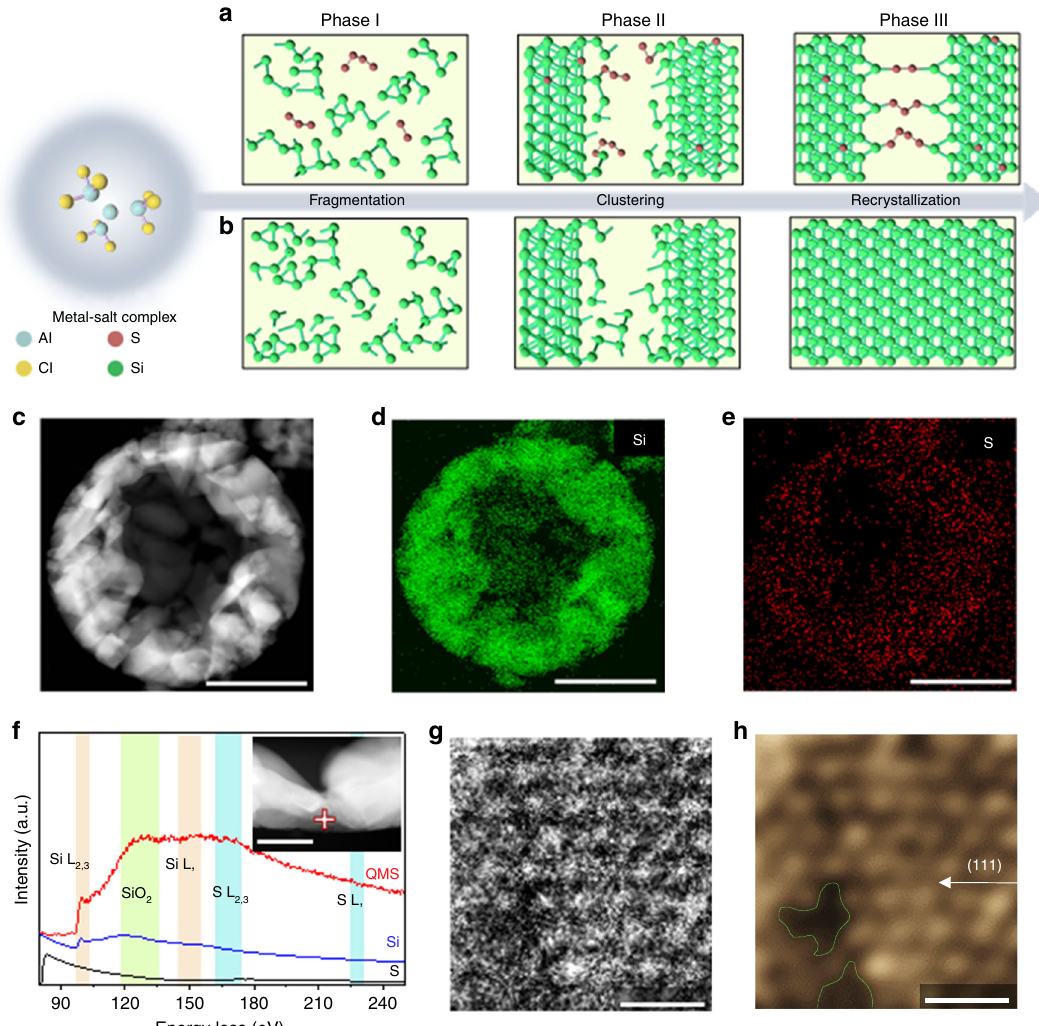
Fig. 1 Structural evolution and characterization of quasi-metallic silicon. a , b Schematic of each stage for ( a ) QMS and ( b ) bare Si. c Scanning transmission electron microscopy (STEM) image. d , e Corresponding energy-dispersive X-ray spectroscopy (EDS) maps for ( d ) Si and ( e ) sulfur. f EELS spectra for elemental sulfur, bare Si, and QMS (inset: STEM image of the EELS measurement position). g , h High-magni fi cation STEM images of QMS. Scale bars, 1 μ m ( c – e ); 50 nm ( f ); 5 Å ( g , h plots for each sample are presented in Fig. 2a. By keeping their microstructures and outer diameters identical, their single- particle conductance can be roughly estimated based on the slopes of the plots. QMS(0.7) exhibits six times higher con- ductance than undoped Si (Fig. 2b). Hereafter, the number in parentheses in the sample labels refers to doping concentration in